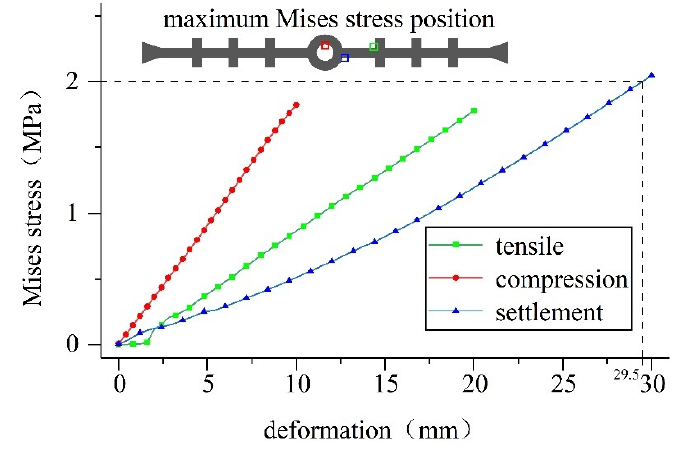
Figure 13. Maximum Mises stress on the waterstop in working condition 1.